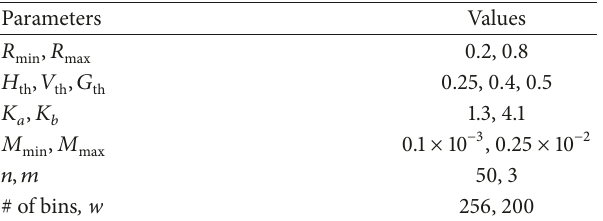
Table 1: Parameter and threshold values used during experiments.